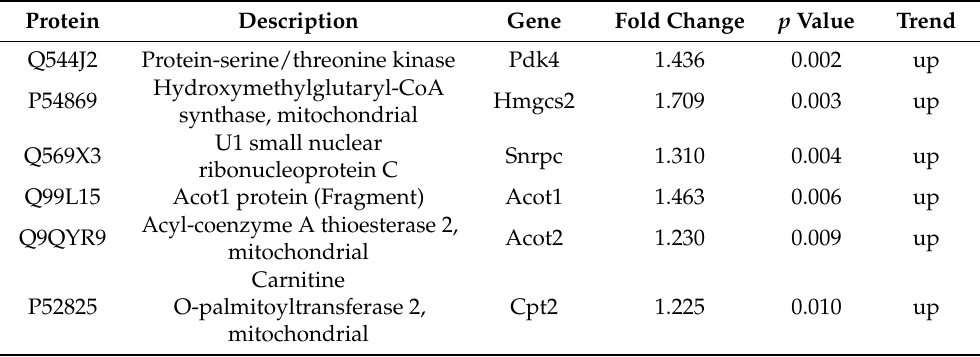
Figure 2. PCA principal component analysis between the control group and the ACM group.